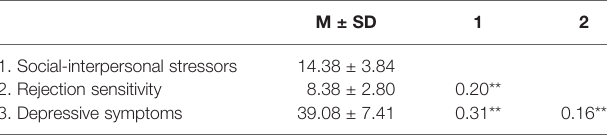
TABLE 2 | Means (M), standard deviations (SD), and correlations for all variables.